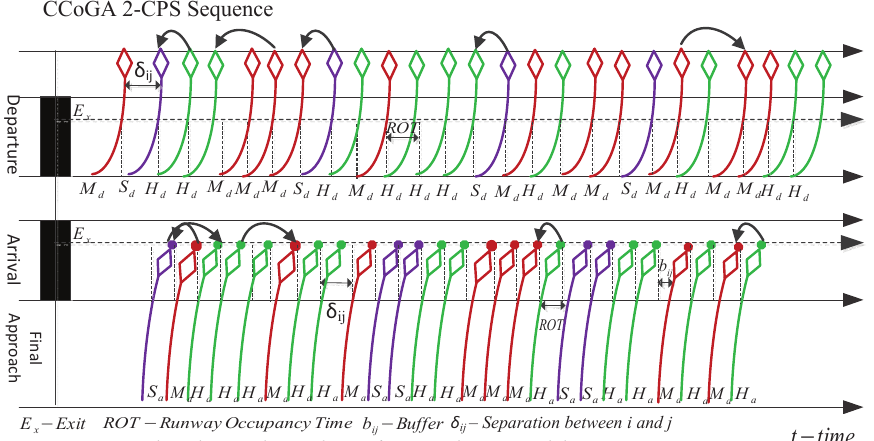
Figure 10. Time-space diagram of the CCoGA 2-CPS sequence: a flight can shift its position either two positions left or two positions right from the FCFS sequence.